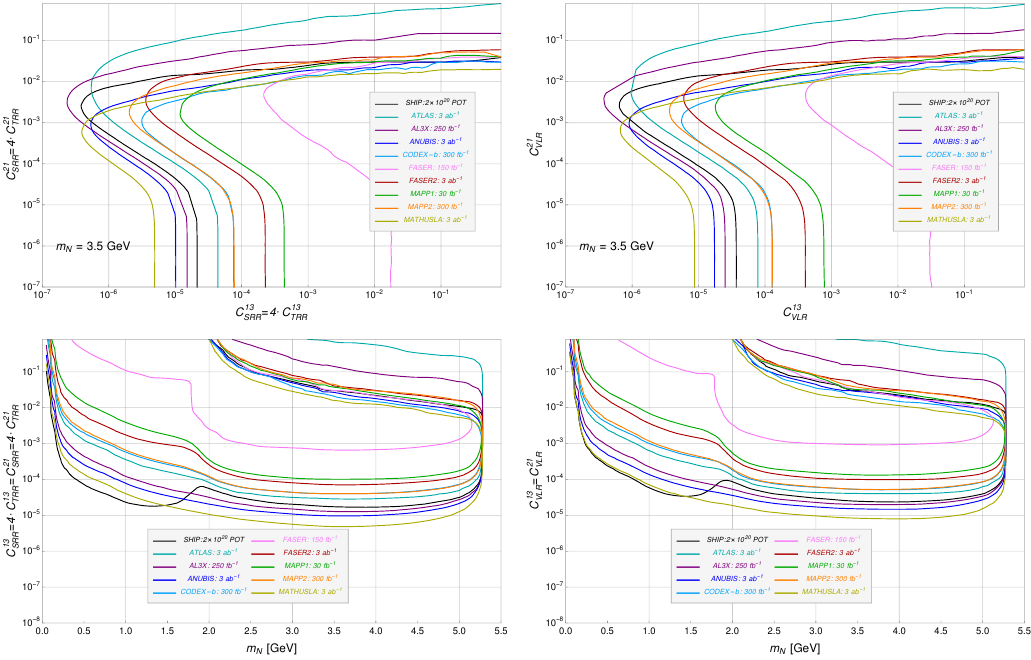
Figure 11 . Results for (cid:13)avor benchmark 5. The format is the same as in (cid:12)gure 7. the reach of C because of the choice for a slightly larger mass of the sterile neutrino. The P two lower plots show sensitivity curves in the plane C lower panels of (cid:12)gure 9, they show similar exclusion limits for m lighter sterile neutrinos, since only the decay modes via the weak current and active-sterile neutrino mixing are open, the sensitivity is signi(cid:12)cantly reduced. The hierarchies of the various experiments is the same as in the previous benchmark for both EFT